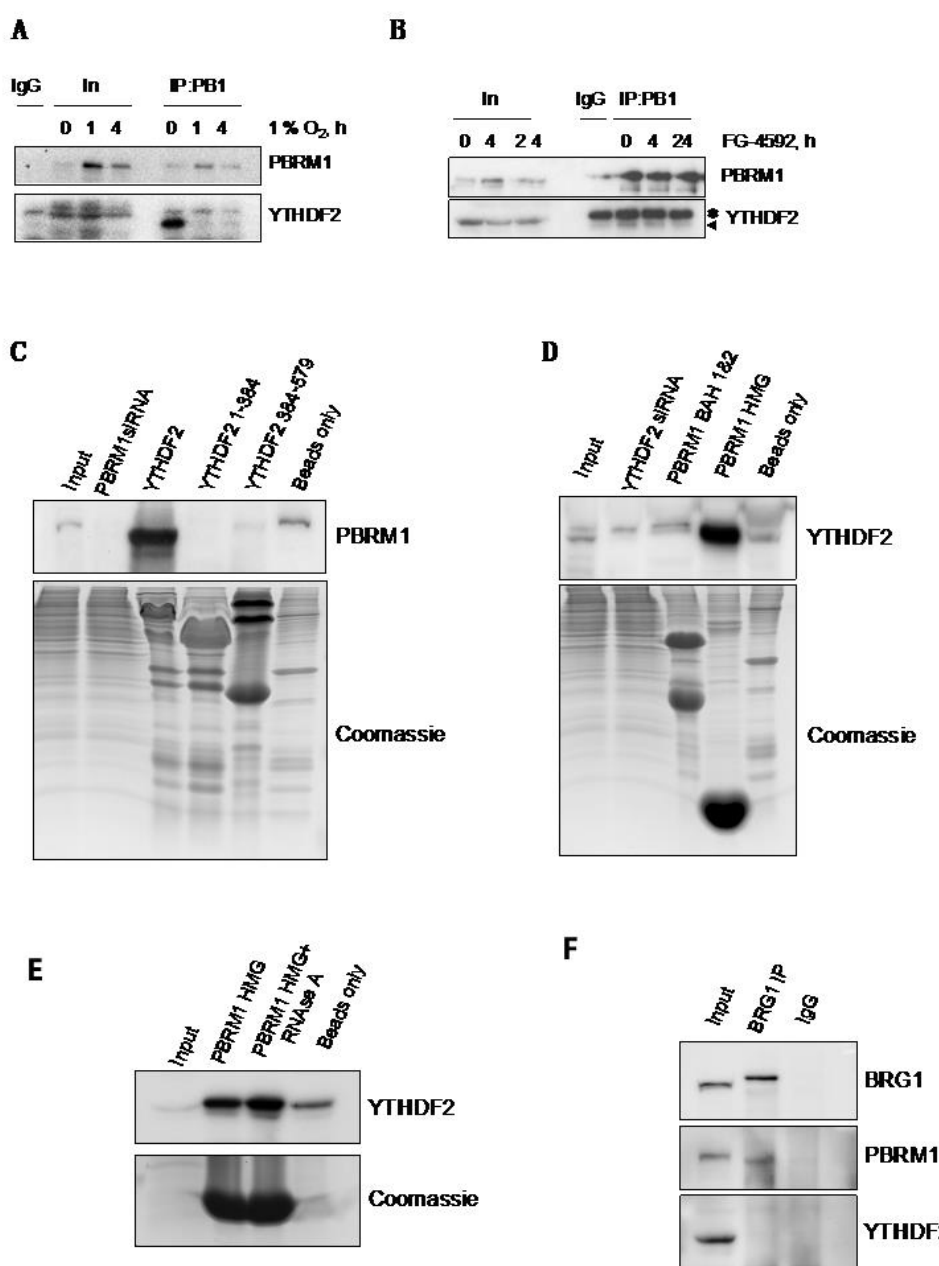
Figure 4. PBRM1 but not BRG1 can bind to the m6A-binding protein YTHDF2 in cells and in vitro. ( A ) The HeLa cells were exposed to 1% O 2 treatments of different duration. The cell lysate in the amount of 500 µg was immunoprecipitated with either the PBRM1 antibody or the IgG control. Levels of PBRM1 and YTHDF2 were determined by Western blotting. Input represents 10% of the protein. ( B ) The HeLa cells were treated with 50 µM of FG-4592 for the indicated periods of time. The cell lysate in the amount of 500 µg was immunoprecipitated with either the PBRM1 antibody or the IgG control. Levels of PBRM1 and YTHDF2 were determined by Western blotting. Input represents 10% of the protein. Note: * indicates a heavy chain, the arrow indicates the YTHDF2 signal. ( C ) Recombinant His-tagged domains of YTHDF2 or ( D ) PBRM1 bound to Ni-NTA beads were incubated with 1 mg of the total HeLa cell lysate overnight at 4 °C and then washed; protein levels were analysed by Western blotting. Input represents 10% of the protein. ( E ) Recombinant His-tagged PBRM1 HMG domains (1394–1462) bound to Ni-NTA beads were incubated with 1 mg of the total HeLa cell lysate overnight at 4 ◦ C with or without 50 µ g of RNAse A and then washed; YTHDF2 levels were analysed by Western blotting. Input represents 10% of the protein. ( F ) The HeLa cell lysate in the amount of 500 µ g was immunoprecipitated with either the BRG1 antibody or the IgG control. Levels of BRG1 and YTHDF2 were determined by Western blotting. Input represents 10% of the